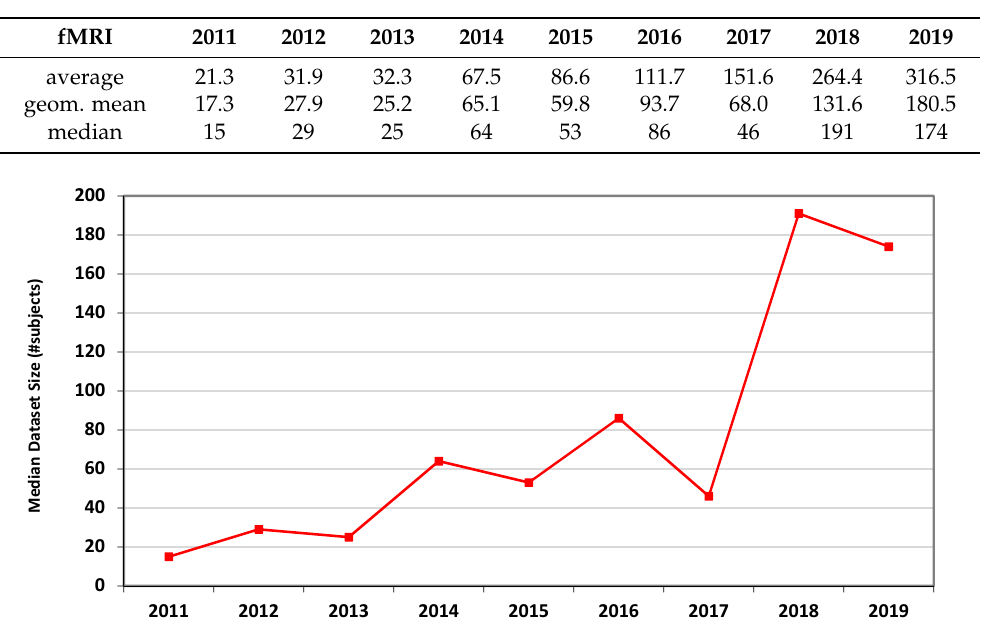
Table 5. Average, geometric mean and median fMRI dataset sizes (number of subjects) used in MICCAI articles in each of the years 2011–2019.